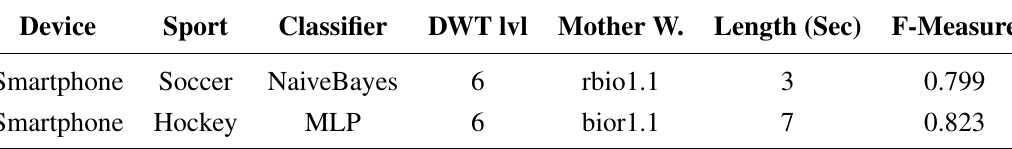
Table 5. Highest classification accuracies attained for Experiment 2.